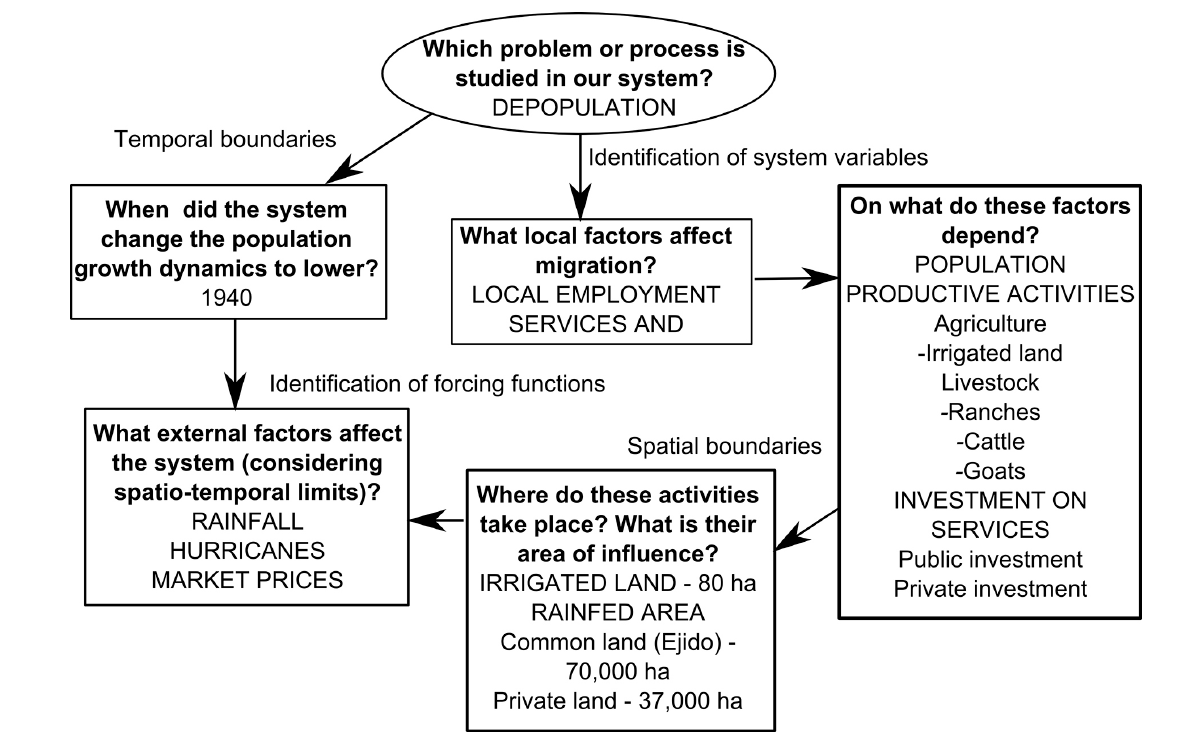
Fig. 5 . Defining system boundaries and components. The sketch summarizes the main issues to define the system, starting from the observed problem.